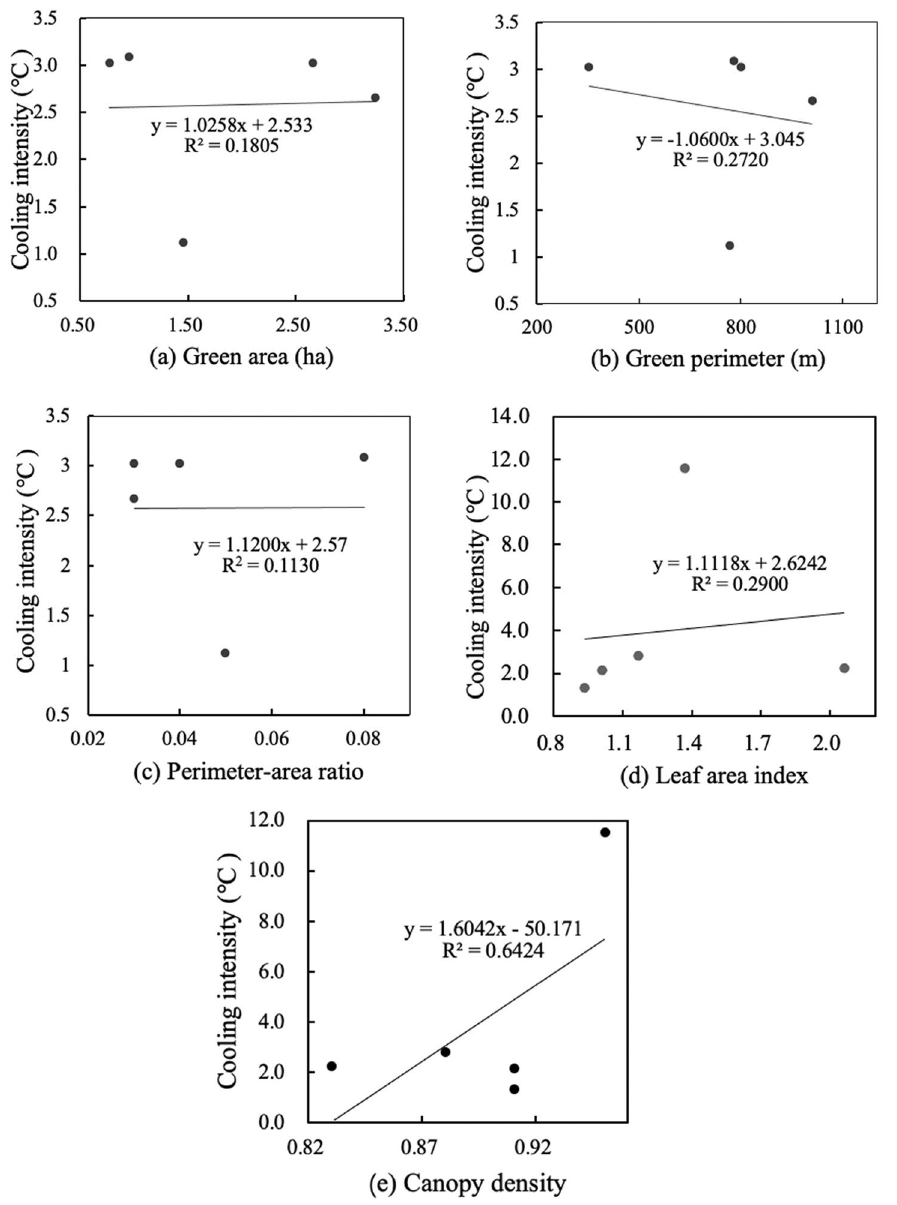
Figure 4. Linear regressions between spatial characteristics and cooling intensity of small-size green